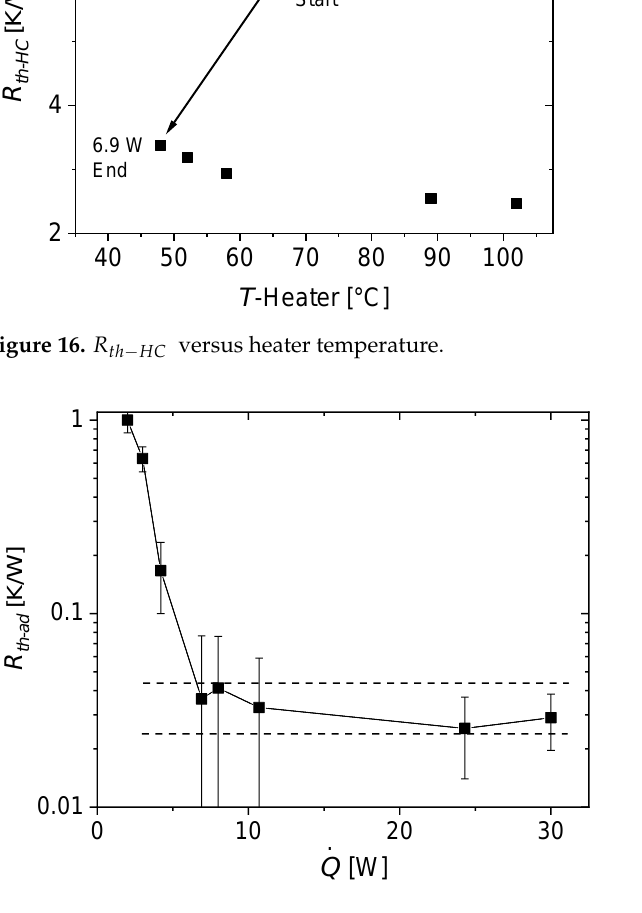
Figure 17. 𝑅 𝑡ℎ−𝑎𝑑 versus heating power with logarithmic y-axis. Solid lines: eye guide. Dashed Figure 17. R th − ad versus heating power with logarithmic y-axis. Solid lines: eye guide. Dashed lines: lines: narrow range of values for 𝑅 𝑡ℎ−𝑎𝑑 when the heat pipe is in the on-state. narrow range of values for R th − ad when the heat pipe is in the